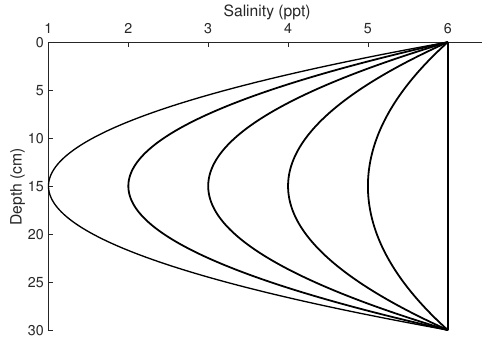
Figure 11. Graphical representation of six salinity profiles. The top and bottom salinity of first-year sea ice are 6 ppt. The salinity at the middle depth ranges from 1 ppt to 6 ppt.